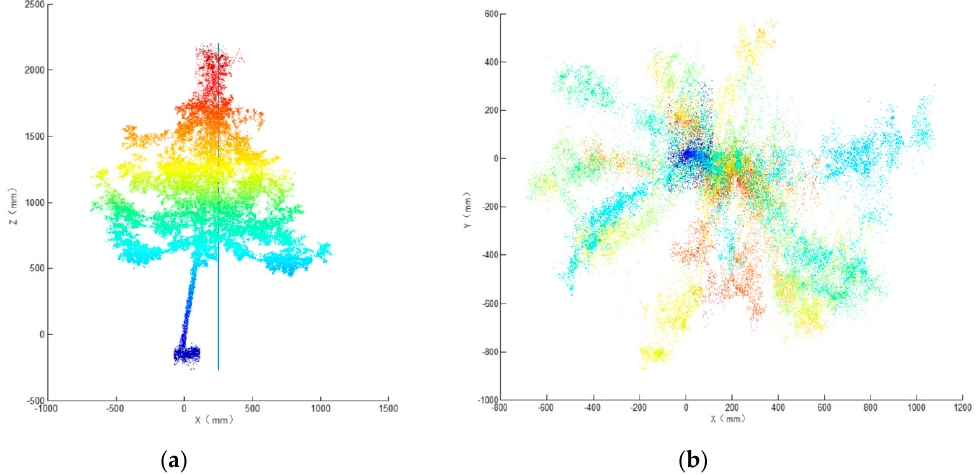
( b ) Figure 7. Model of the fruit tree 3D point cloud after precise registration via iterative closest point (ICP): ( a ) 3D point cloud of fruit tree after ICP (image with original color); ( b ) 3D point cloud of fruit tree after ICP (image with coloration).